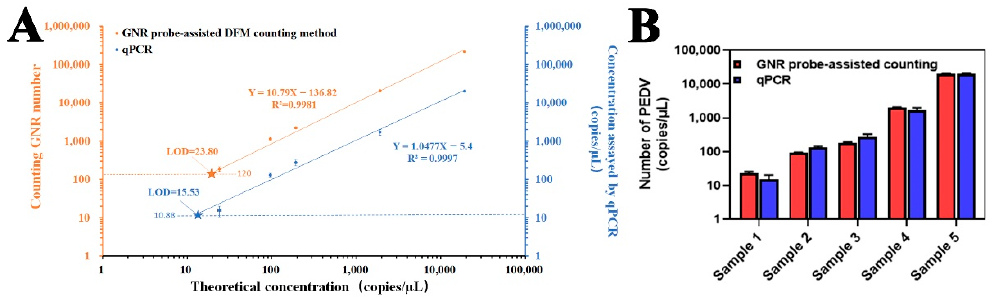
Figure 8. GNR probe-assisted counting of PEDV in simulated real samples. Representative DFM image of PEDV antibody-immobilized chip incubated with GNR probe at different concentrations of PEDV present in mouse serum. ( A ) Calibration curves of DFM counting and qPCR. The pentagram is the intersection of the calibration curve with three times signal-to-noise ratio. ( B ) Comparison of the results of GNR probe-assisted counting method with those of qPCR method. The concen- trations of sample 1–5 are 2.4 × 10 1 copies/ μ L, 9.6 × 10 1 copies/ μ L, 1.92 × 10 2 copies/ μ L, 1.92 × 10 3 copies/ μ L and 1.92 × 10 4 copies/ μ L, respectively. The values of GNR probe-assisted counting method are calculated from the standard curve in Figure 7G.